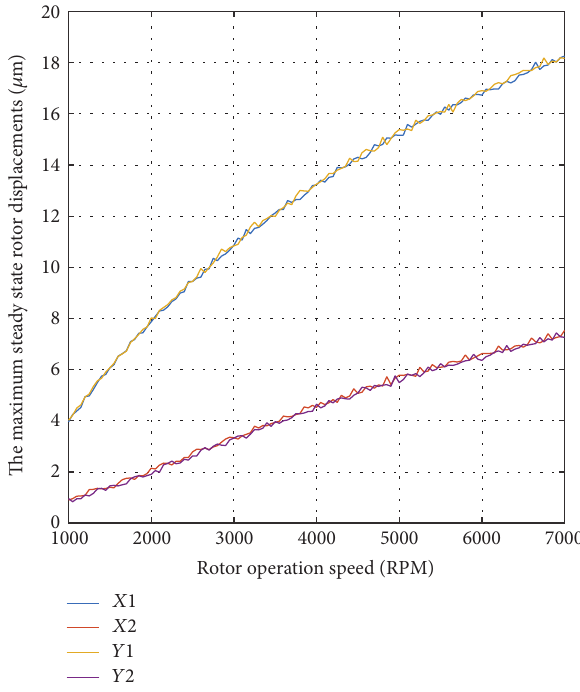
Figure 20: The maximum steady-state rotor displacements without unbalance control.